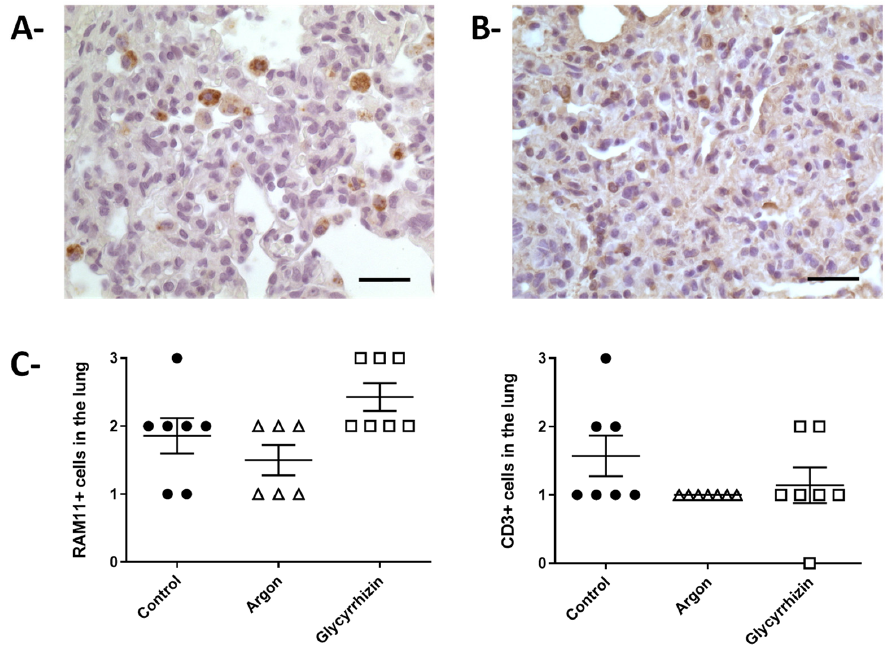
Figure 6. Immunochemistry in lung parenchyma. ( A )—Morphological appearance of the immunohistochemical staining for macrophage identification using the RAM11 polyclonal antibody (bar = 25 µ m). ( B )—Morphological appearance of the immunohistochemical staining for T cells identification using a CD3 antibody (bar = 25 µ m). ( C )—Semiquantification of RAM11 and CD3 positive cells in the pulmonary samples from the different groups.